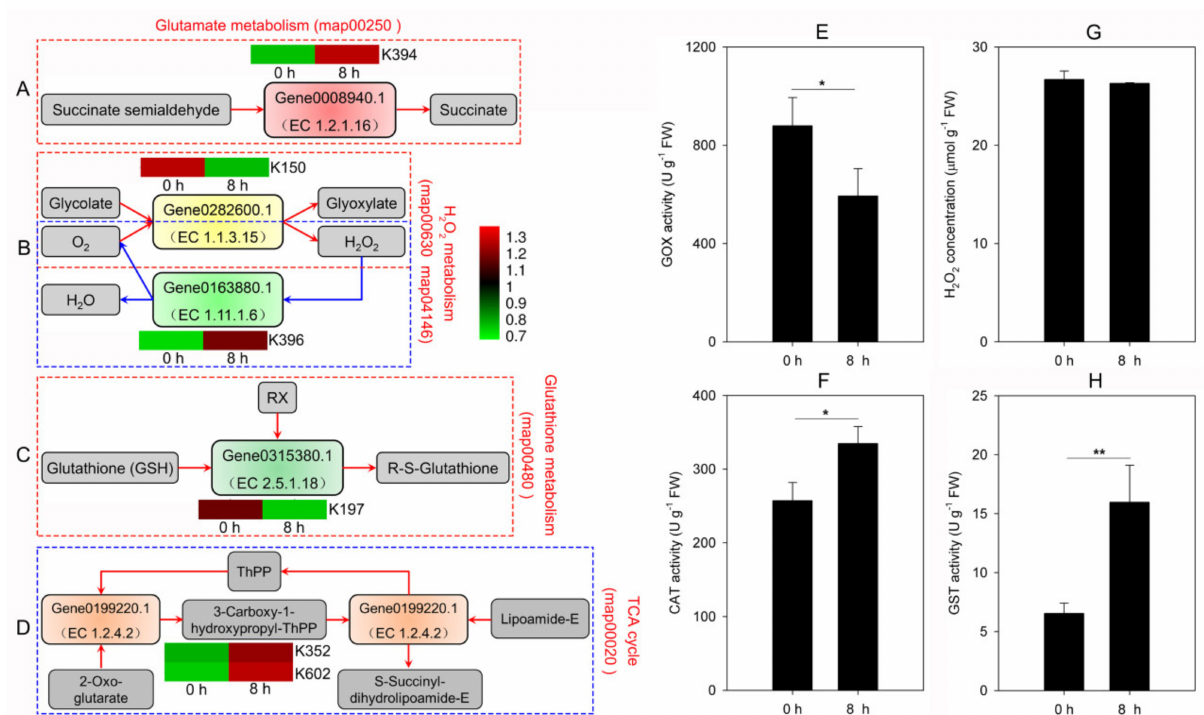
Figure 6. The main reactions catalyzed by the differentially succinylated proteinous enzymes and the corresponding enzyme activity or product concentrations in the shoots of turnip seedlings. ( A ) The reaction catalyzed by succinate-semialdehyde dehydrogenase (Gene0008940.1); ( B ) The reactions catalyzed by glycolate oxidase (GOX; Gene0282600.1) and catalase (CAT; Gene0163880.1); ( C ) The reactions catalyzed by glutathione S-transferase (GST; Gene0315380.1); ( D ) The reactions catalyzed by 2-oxoglutarate dehydrogenase (Gene0199220.1); ( E ) GOX activity in the shoots of turnip seedlings; ( F ) CAT activity in the shoots of turnip seedlings; ( G ) H 2 O 2 concentration in the shoots of